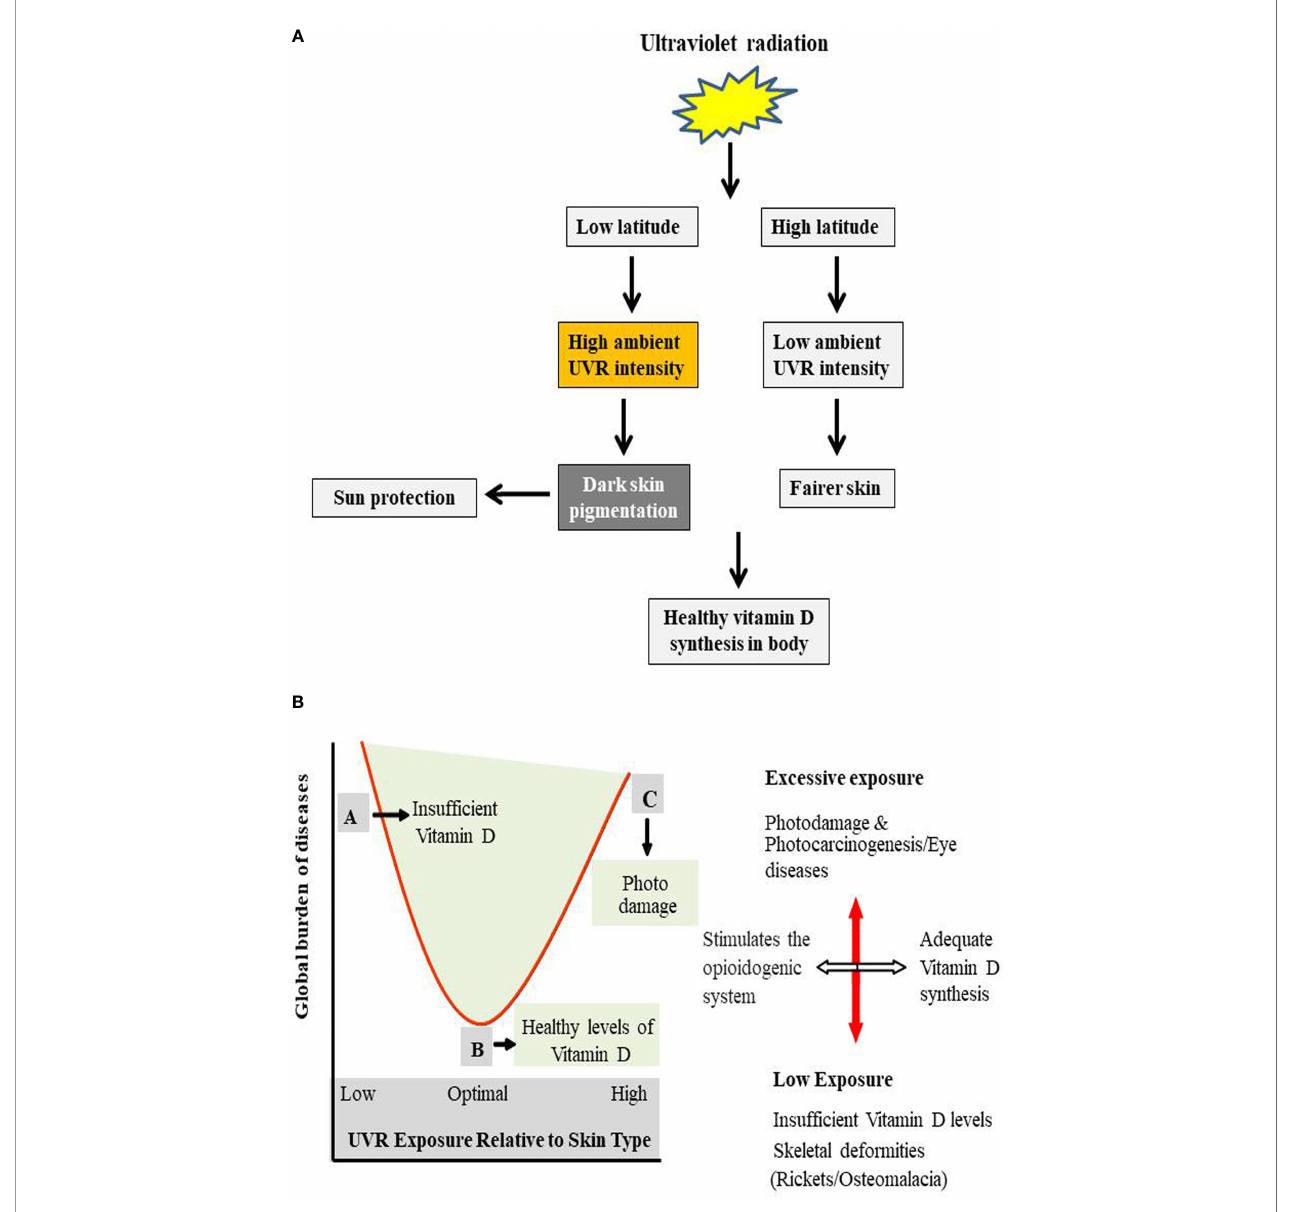
FIGURE 1 | (A) Evolutionarily mediated adaptation of life forms to differential atmospheric UVR levels. UV radiation exposure requirements promoting healthy vitamin D synthesis in skin meant that people developed darker skin pigmentation at places of low latitude with high ambient UVR intensity, offering them protection from the effects of UVR. While, those at higher latitude have fairer skin as an evolutionarily developed trait to potentiate the insuf fi cient vitamin D production from low ambient exposure of UV to skin. (B) Ambivalent effects of UVR exposure to skin. Schematic diagram showing relationship between bene fi ts of optimum UVR exposure, ill effects of inadequate exposure and the global burden of diseases due to inappropriate UV exposure. A represents insuf fi cient UVR exposure responsible for the improper vitamin D levels in the body leading to skeletal abnormalities and other indirect effects of low ambient UV exposure. B represents optimal UVR exposure required for the essential and healthy synthesis of vitamin D in the body and also stimulates the opioidogenic system in the brain. C shows high UVR exposure leading to skin and ocular malignancies especially, in fair-skinned individuals. Both A & C are related to inappropriate exposure of UVR to the